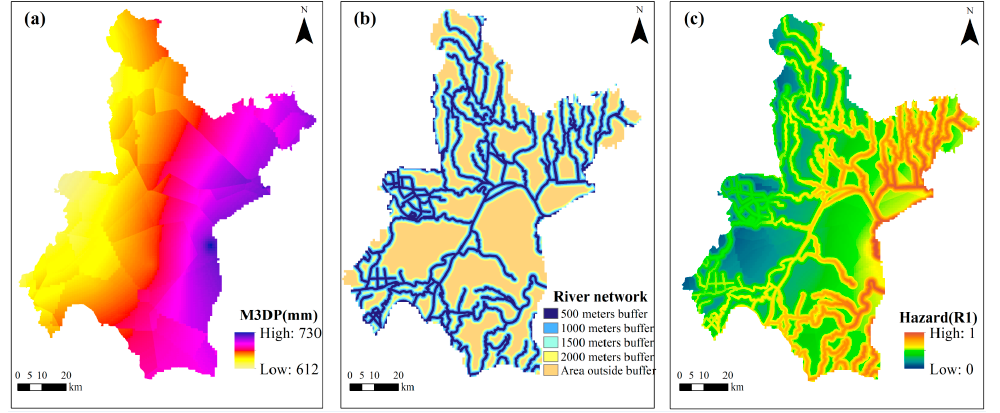
Figure 3. Spatial pattern of average M3DP ( a ), river network ( b ), buffer, and Hazard ( c ) in Wuhan during 2000–2018.